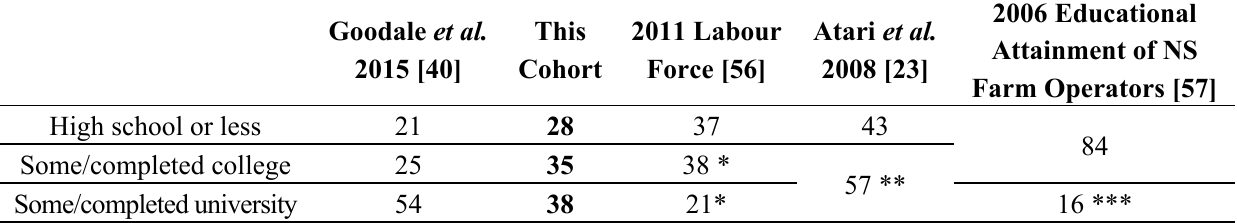
Table 1. Educational attainment of this cohort (%) in comparison with other survey results of the NSFA membership (Goodale et al. 2015; Atari et al. 2008), the 2011 Canadian Census general labour force, and the 2006 educational attainment of farm operators in the province of Nova